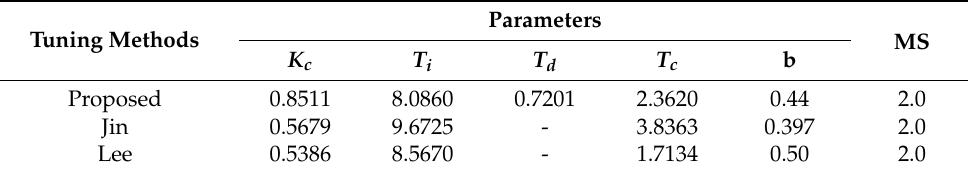
Table 4. Parameter tuning for process P 2